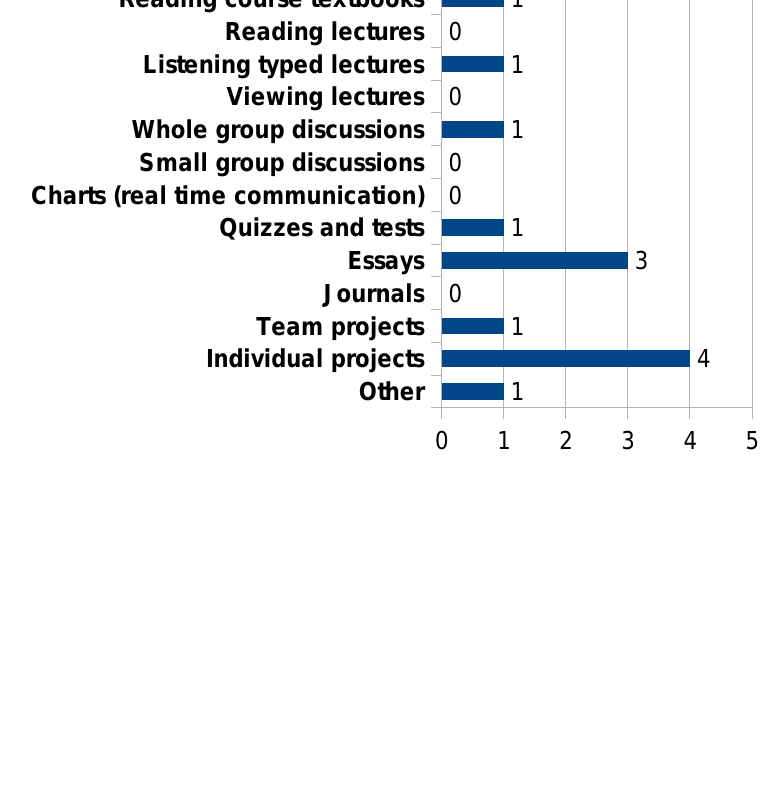
Figure 4 . Question 9